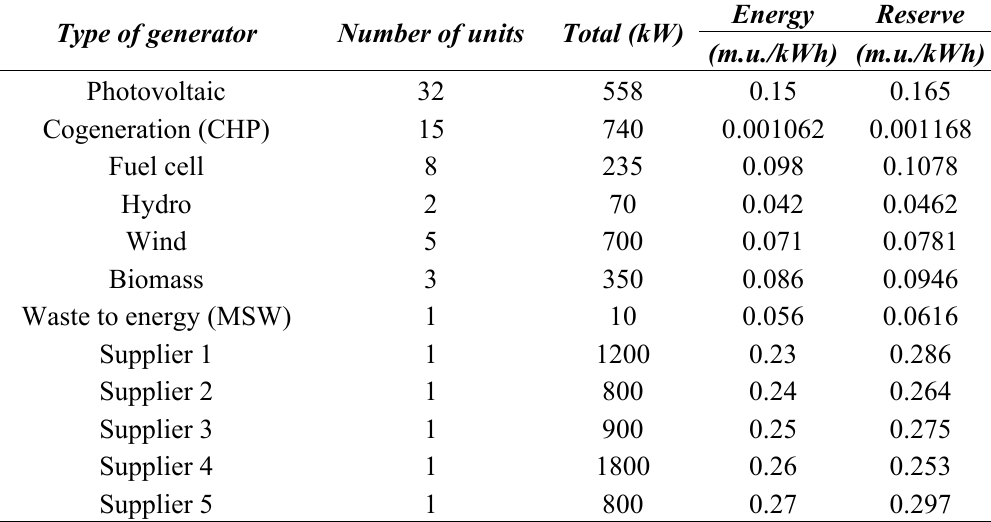
Table 1. Generators’ characteristics and bid prices.